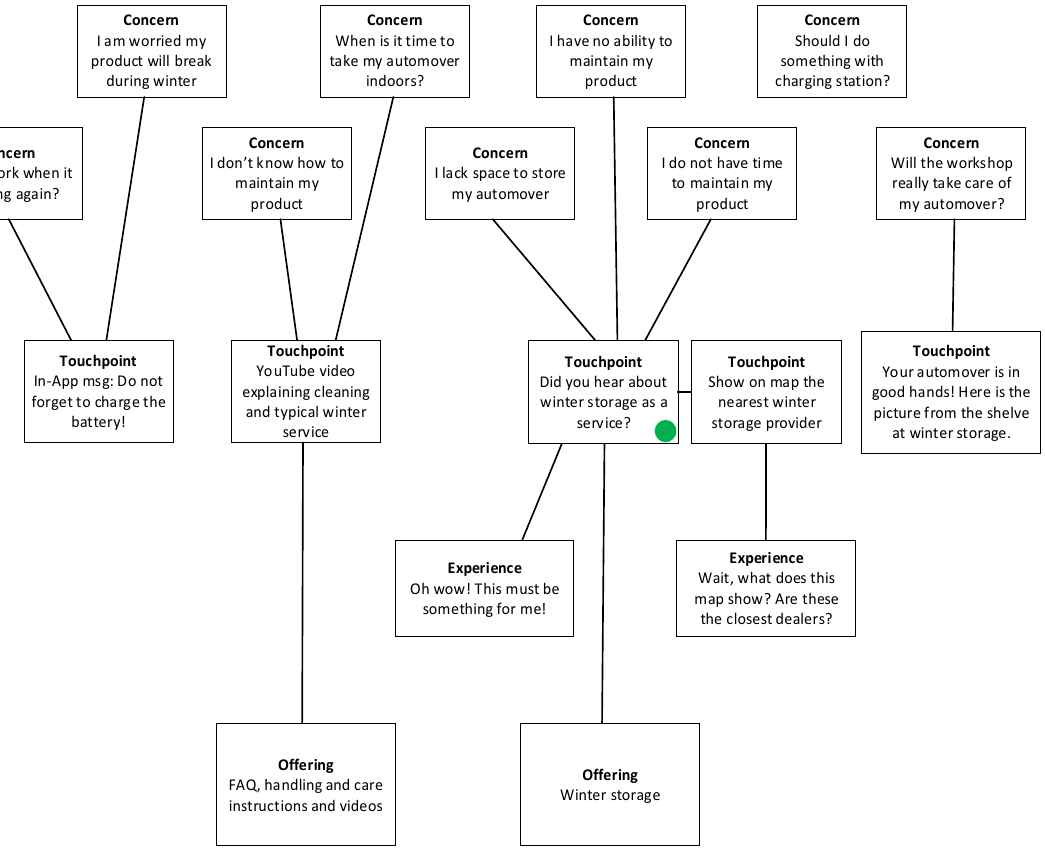
Figure 12. Customer concerns, touchpoints and